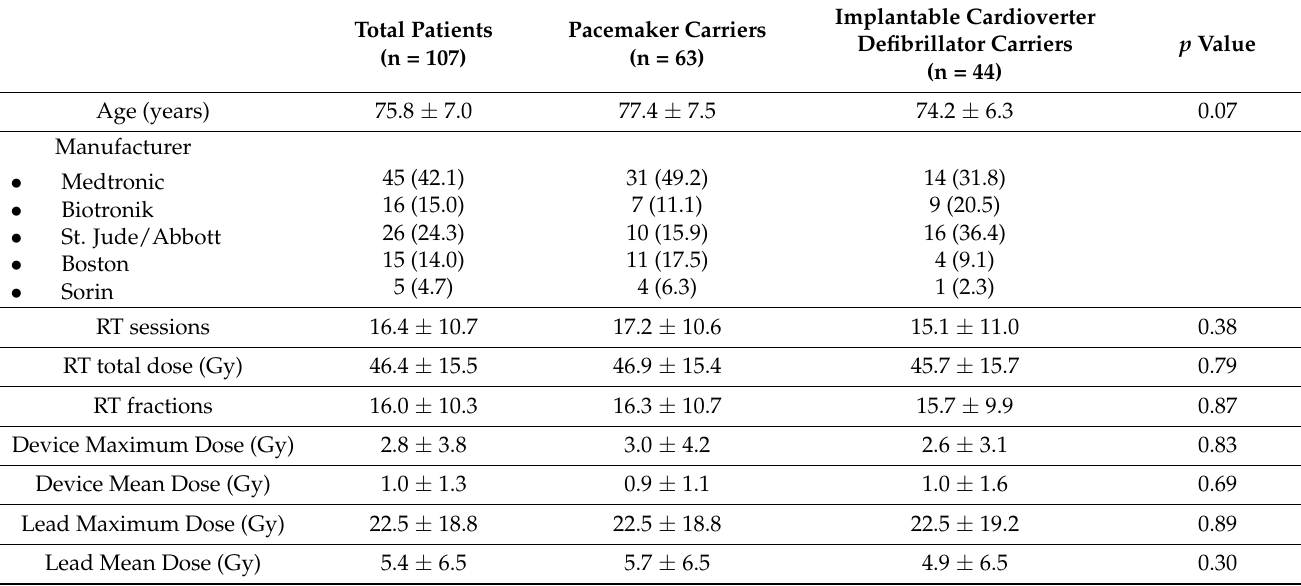
Results are reported as n (%) for categorical variables and mean ± standard deviation for continuous variables.